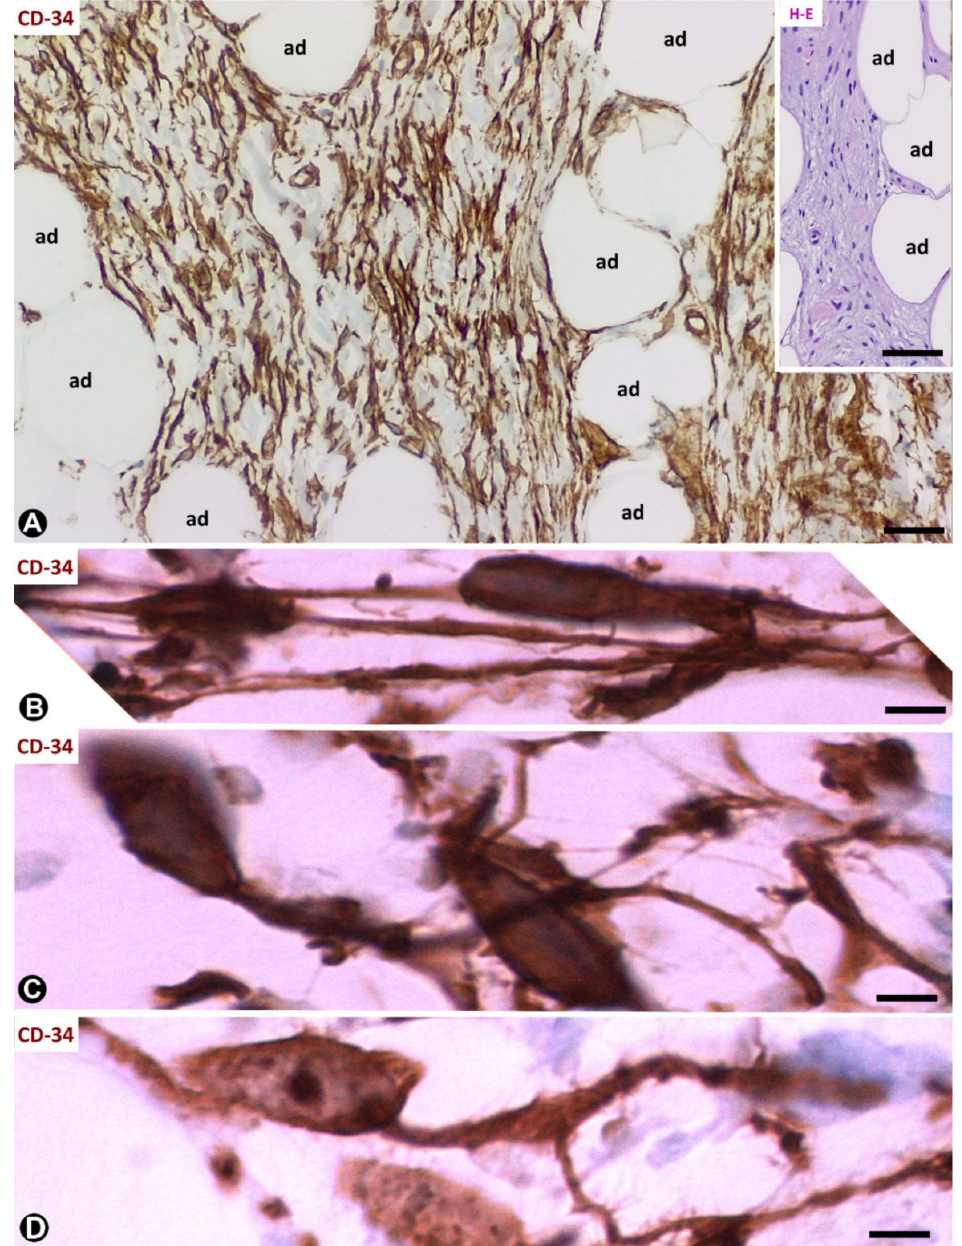
Figure 6. Spindle cell lipoma. ( A ): CD34 + spindle cells (brown) are observed between adipose cells (ad). Insert shows an image with haematoxylin–eosin (HE) staining in which it is di ffi cult to distinguish processes from spindle cells. ( B – D ): CD34 + spindle cells with bipolar processes ( B ), piriform aspect with a single ( C ) and branched ( D ) process. ( A – D ): CD34 immunochemistry; haematoxylin counterstain. Bar: ( A ): 80 µ m; (insert of ( A )): 100 µ m; ( B – D ): 10 µ